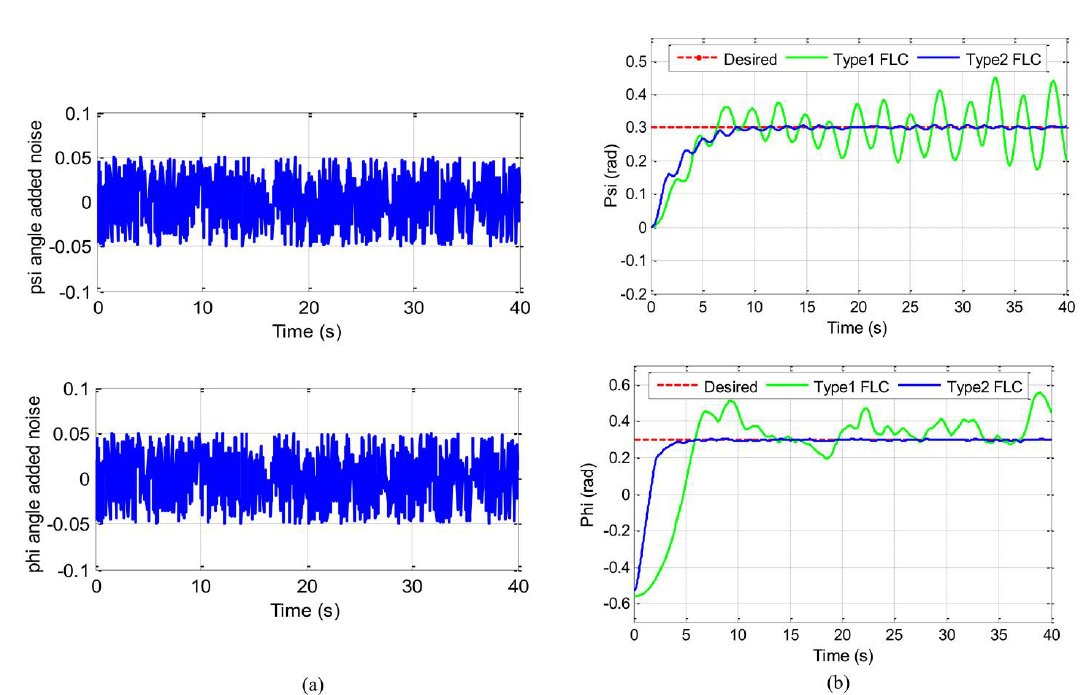
Figure 12. Robustness test to measurement noise (a) Noise added to the ψ and φ angles. (b) The resulting ψ and φ angles after application in presence of measurement noises.